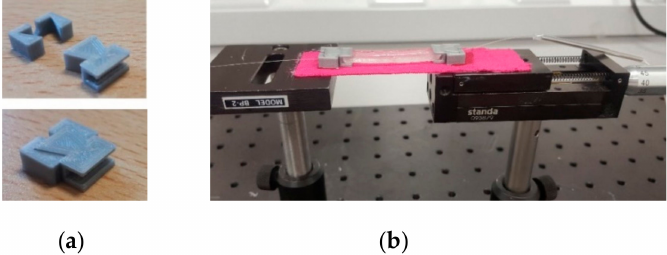
Figure 4. ( a ) Polylatic acid 3D printed adaptors for the sensing resin block; ( b ) Experimental set up for strain characterization with the assembled sensing block: optical fiber in-line FPI integrated in a resin structure, incorporated in the 3D adaptors and attached to the adhesive biocompatible elastic